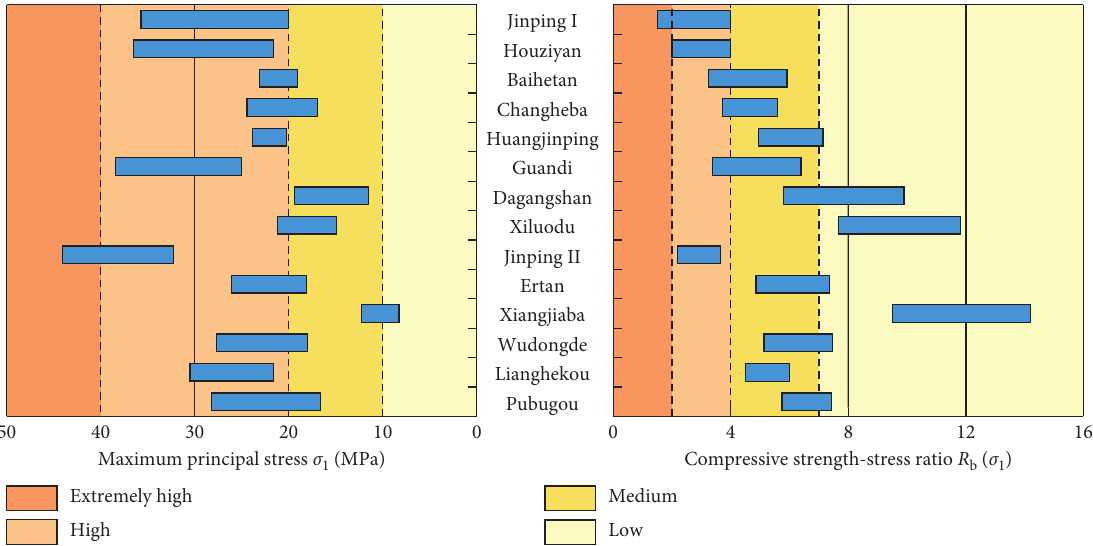
Figure 9: In situ stress rating results of fourteen domestic large-scale underground powerhouses.